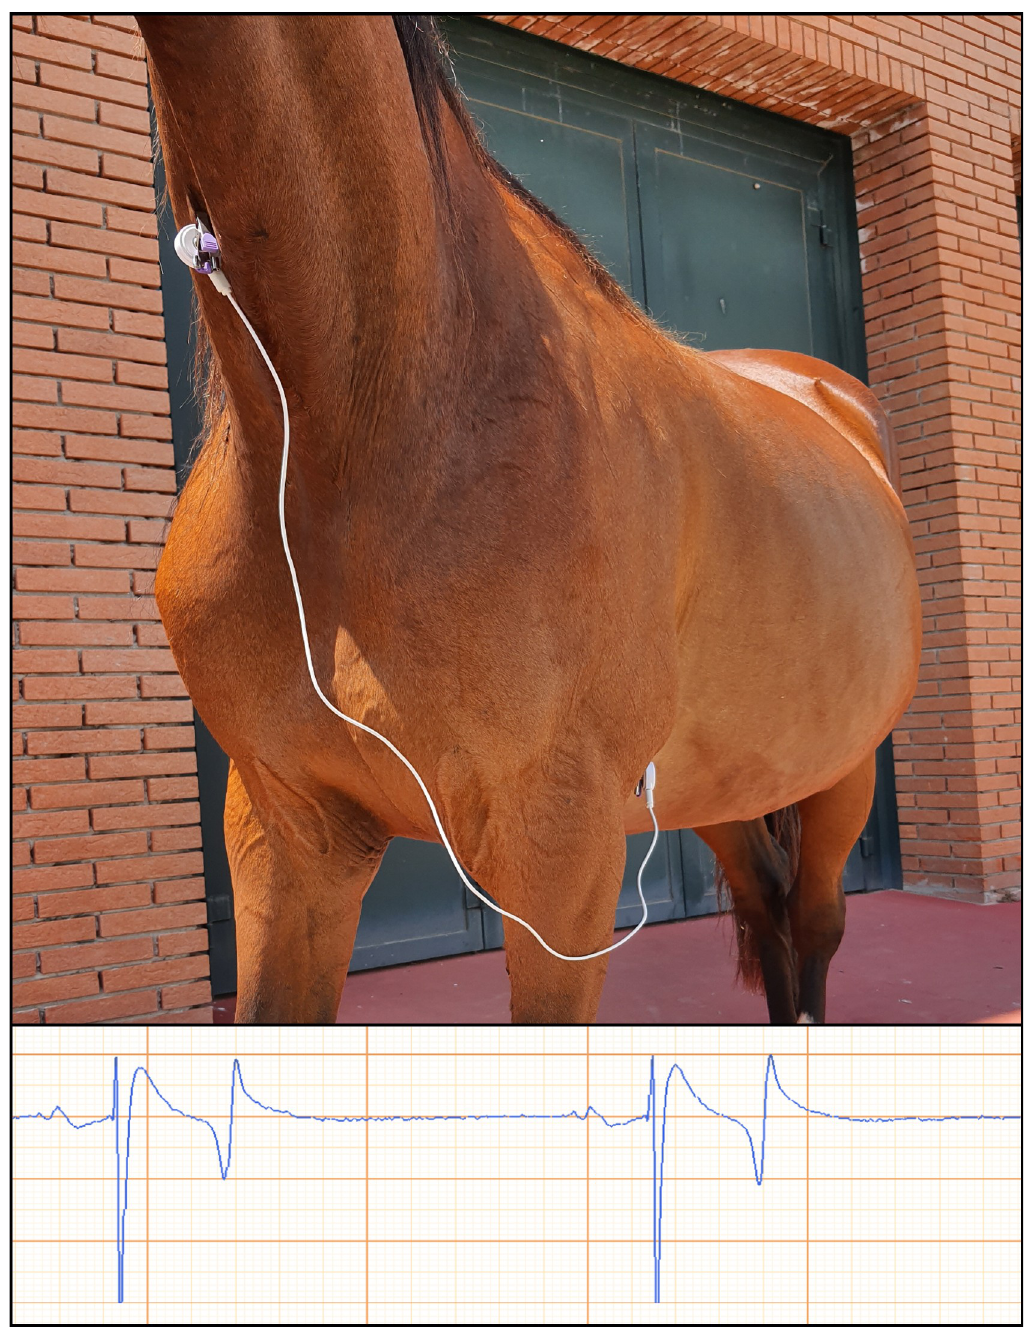
Fig 2. Standard base-apex (SBA) placement of the smartphone ECG (spECG) electrodes. complexes could not be identified. The same operator performed also the ECG measurements on all tracings, using lead I of the rECG and the only available lead of the spECG. The follow- ing variables were measured for both rECG and spECG in each recording session: mean heart rate (HR; bpm), P-wave duration (milliseconds [ms]), PQ interval (ms), QRS complex dura- tion (ms), and QT interval (ms). Heart rate (HR) was calculated counting the number of QRS